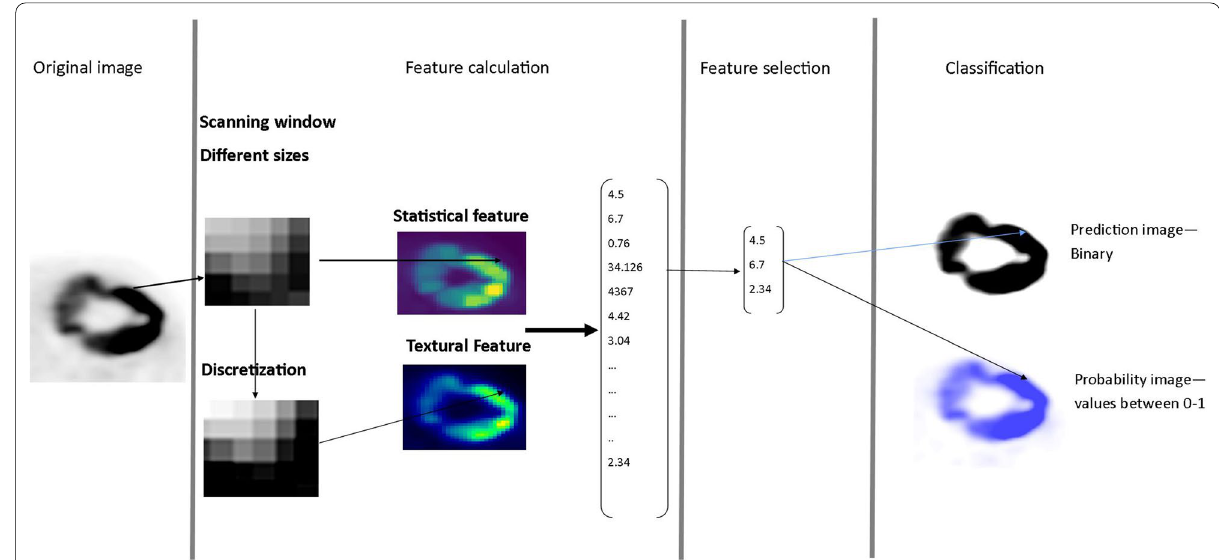
Fig. 3 Workflow of the textural feature-based segmentation for the axial